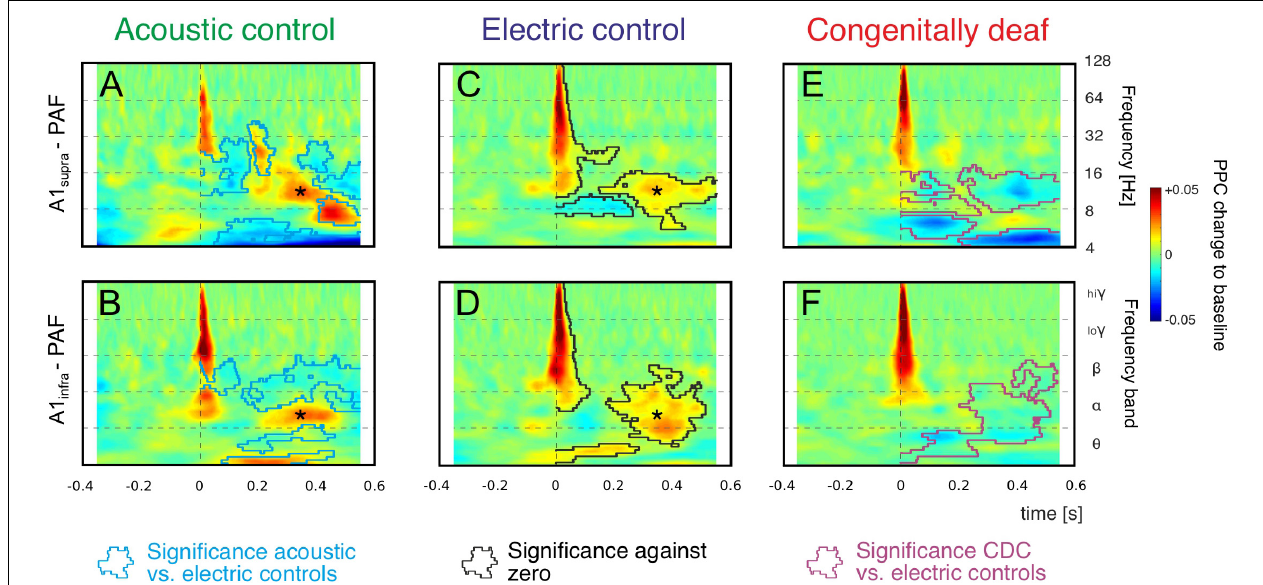
FIGURE 4 | Grand mean averages of time-frequency-based functional connectivity between A1 and PAF computed using pairwise phase consistency (PPC). Functional connectivity computed separately for supragranular layers in A1 (A1 supra – PAF, top) and infragranular layers in A1 (A1 infra – PAF, bottom) reveal onset responses (near 0 ms) and late responses ( > 200 ms). Warm (yellow and red) colors represent an increase in synchronization relative to baseline, i.e., a stimulus-related functional connection. (A,B) : Acoustic controls: Regions with significant differences to electric controls are outlined with blue lines (non-parametric cluster-based permutation statistical testing, two-tail significant α value = 0.25%). (C,D) Electric controls: Regions of significant PPC change to zero are outlined by black lines (comparison to zero, two-tail significant α value = 0.25%), statistical differences to acoustic controls are shown in (A,B) as blue lines (non-parametric cluster-based permutation statistical testing, cluster α threshold 0.5%, two-tail significant α value = 0.25%). Alpha band synchronization in the late window (asterisk) is observed in both control groups consistently. (E,F) In CDCs, only onset couplings are preserved, all late ( > 200 ms) couplings disappeared. Regions with significant differences to electric controls are outlined with magenta lines (non-parametric cluster-based permutation statistical testing, two-tail significant α value =